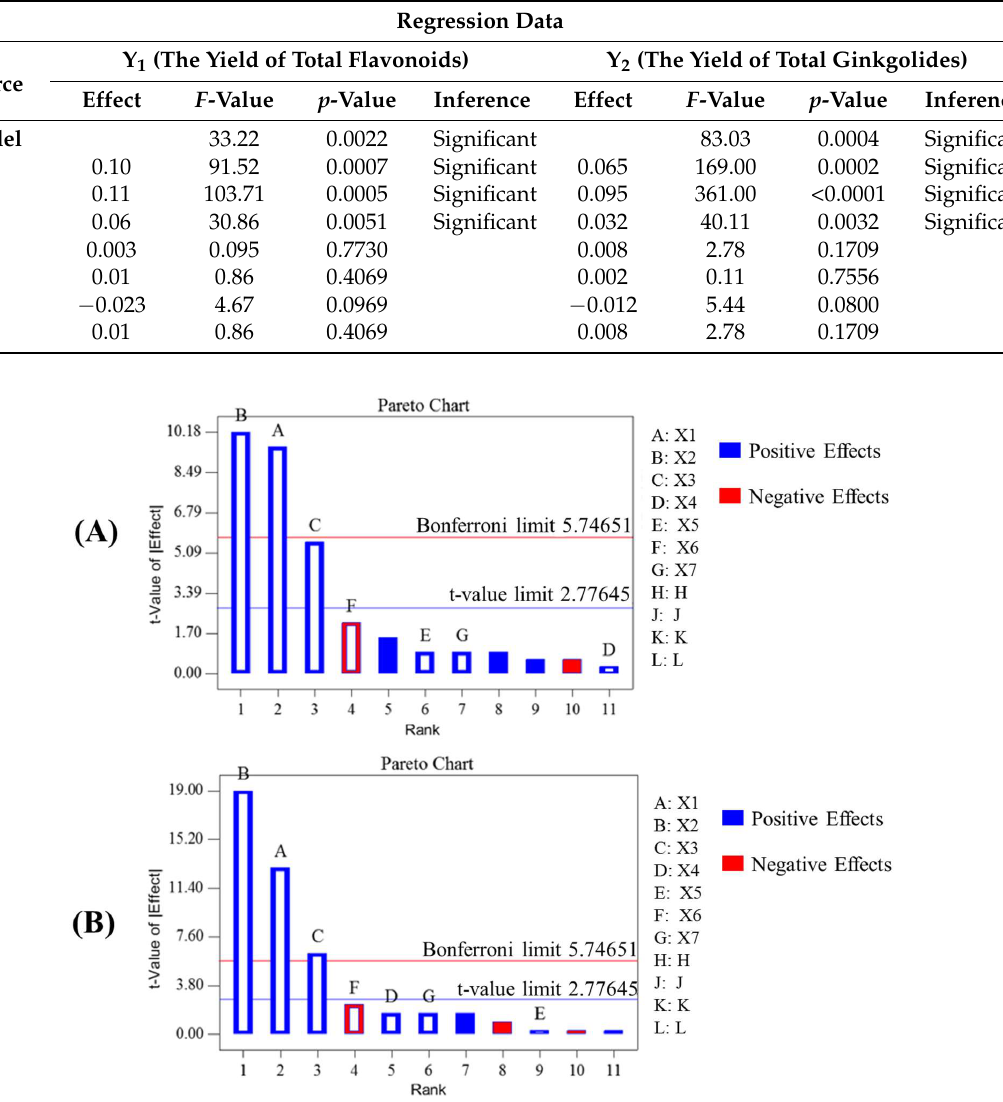
Table 3. Analysis of variance and regression analysis of Plackett-Burman design data for the prediction of significant extraction variables.